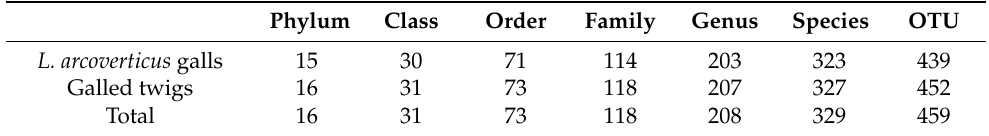
Table 1. The total number of bacteria in Lithosaphonecrus arcoverticus galls and the galled twigs of